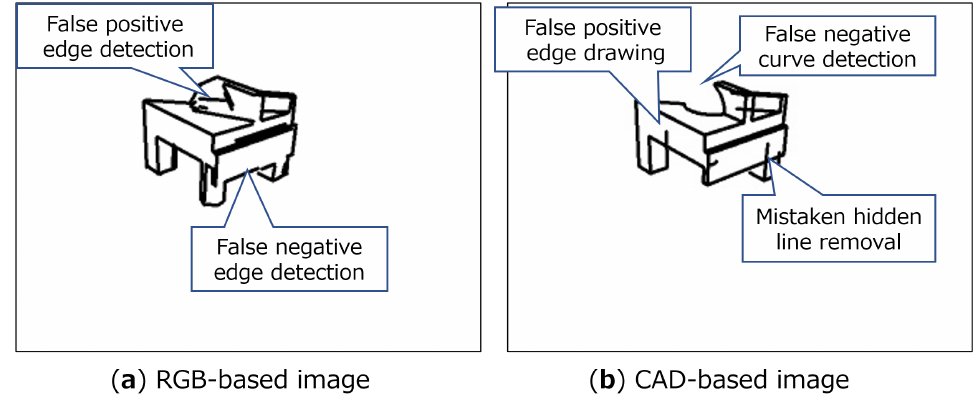
Figure 8. An example of the difference between RGB-based and CAD-based